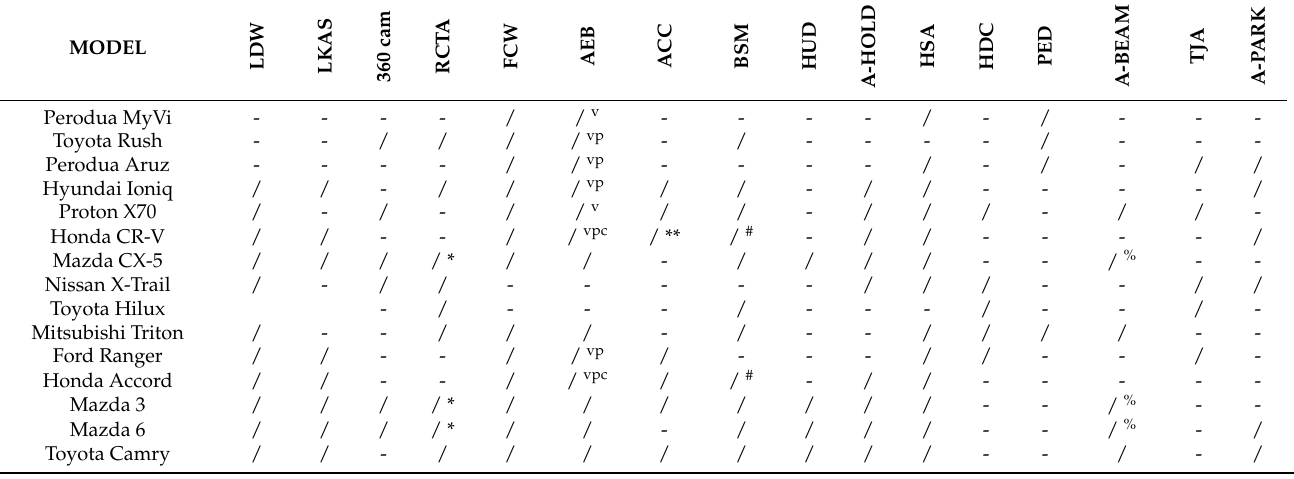
Table 2. Available advanced driver-assistance systems based on vehicle